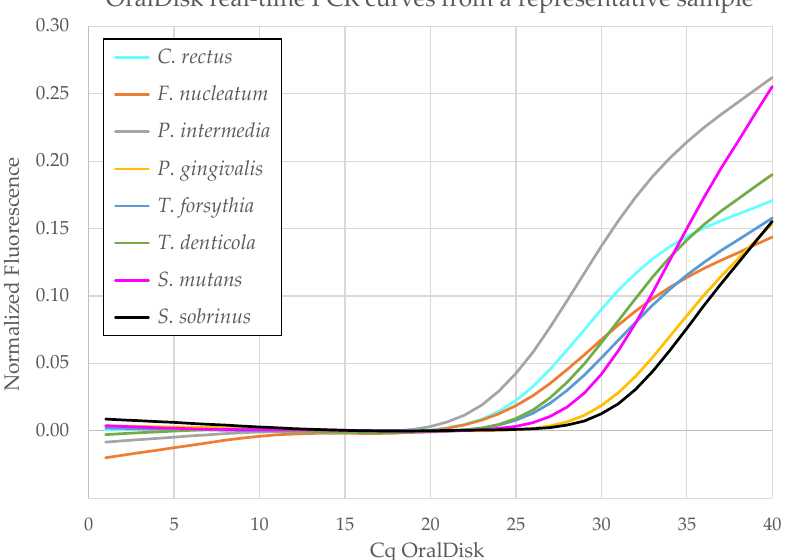
Figure 4. Representative real-time PCR curves for the oral bacteria detected with the OralDisk in one whole saliva sample.